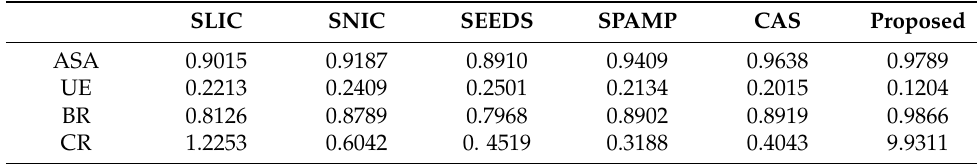
Table 1. Segmentation metrics of SI 2 by four methods. SLIC SNIC SEEDS SPAMP CAS